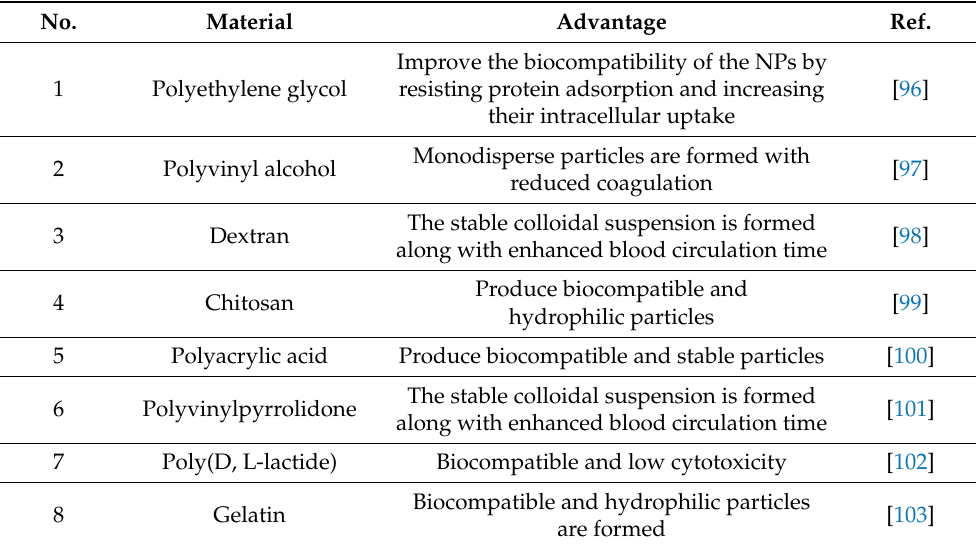
Table 2. Commonly used polymers for magnetic nanoparticle